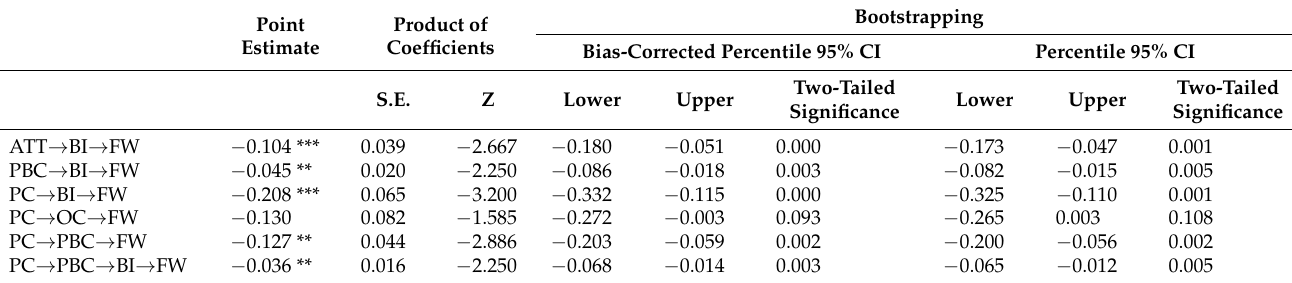
Table 5. Results of bootstrap test.